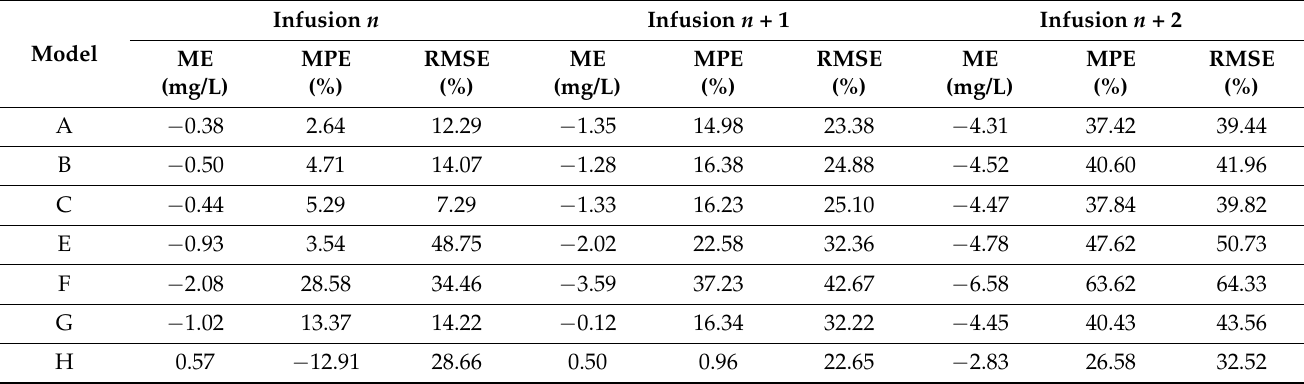
Table 5. Simulation results of the n th, ( n + 1)th, and ( n + 2)th infusions for 7 models.